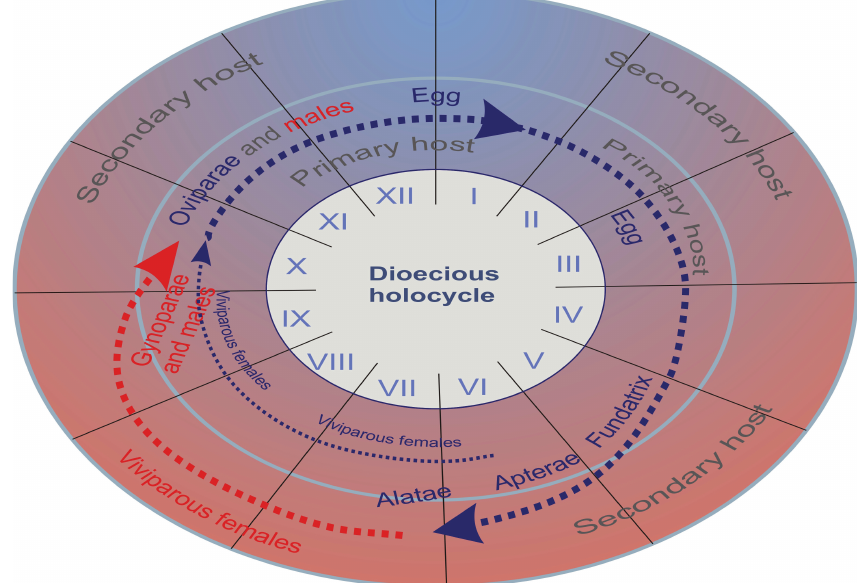
Fig. 3. Dioecious one-year holocycle ( Rhopalosiphum padi ). the inner zone represents the primary host (bird cherry, Prunus padus and allies), the outer zone the secondary (usually graminoids). the fundatrix gives birth to apterae, which in turn give birth to alatae, most of which migrate to the secondary hosts. In autumn males and gynoparae (viviparae giving birth to oviparae) migrate to the primary host, where mating and egg-laying take place. A small fraction of the viviparae may remain on the primary host throughout the